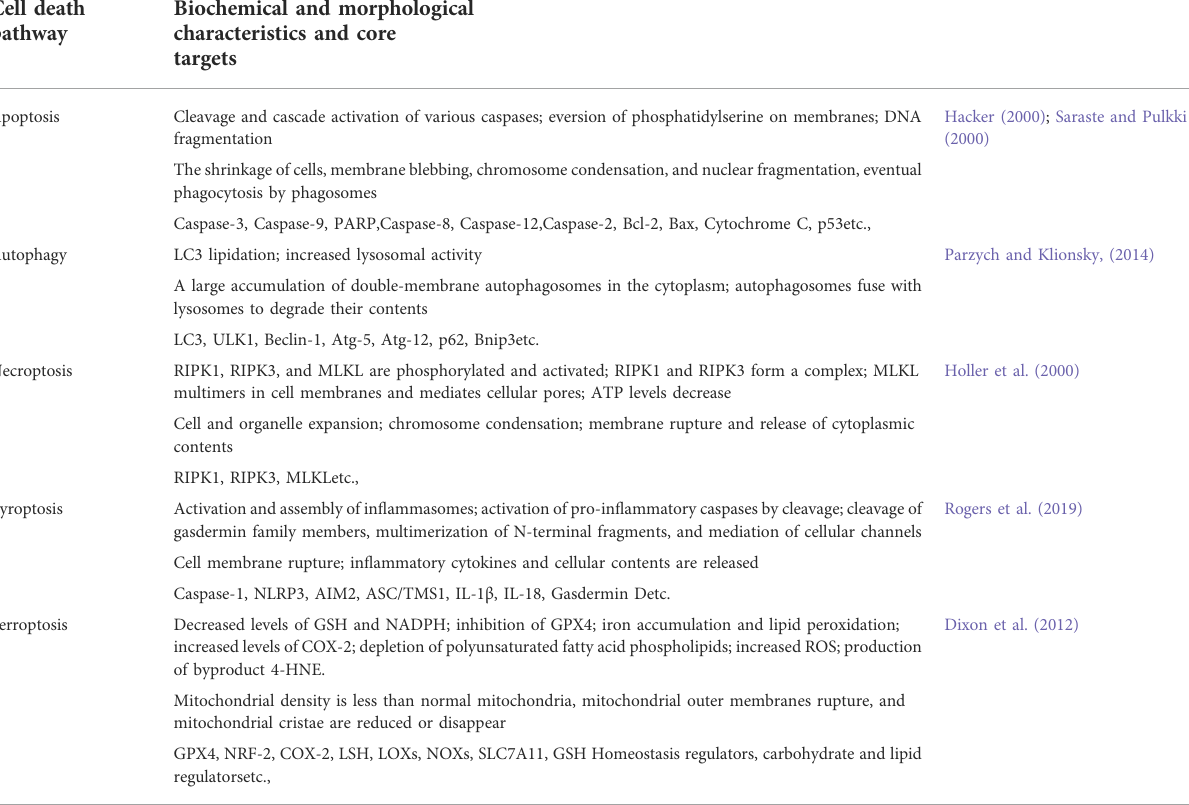
TABLE 1 Pathways of cell death and associated morphological and biochemical